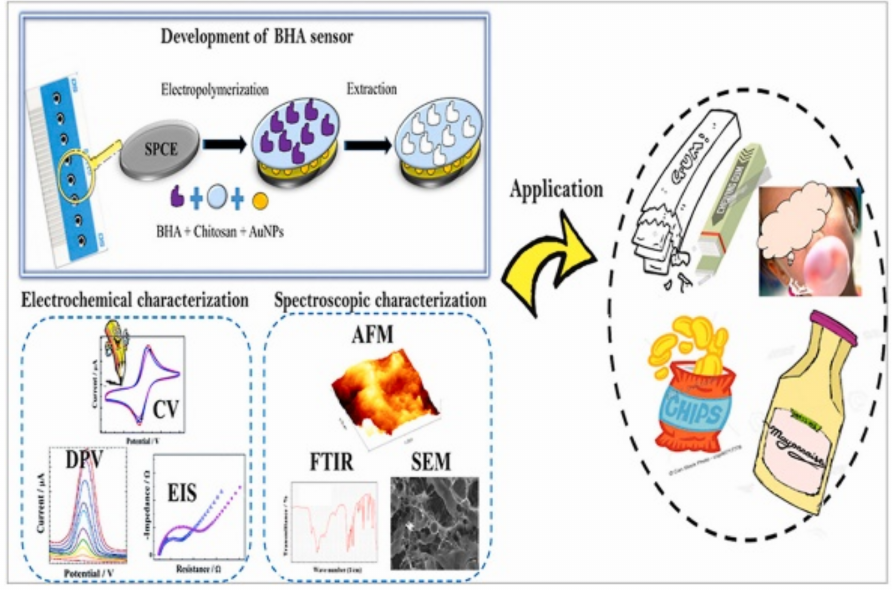
Figure 11. Schematic representation of the butylated hydroxyanisole (BHA) sensor assembling, characterization, and application. Reprinted with the permission from reference [128]. Copyright 2021